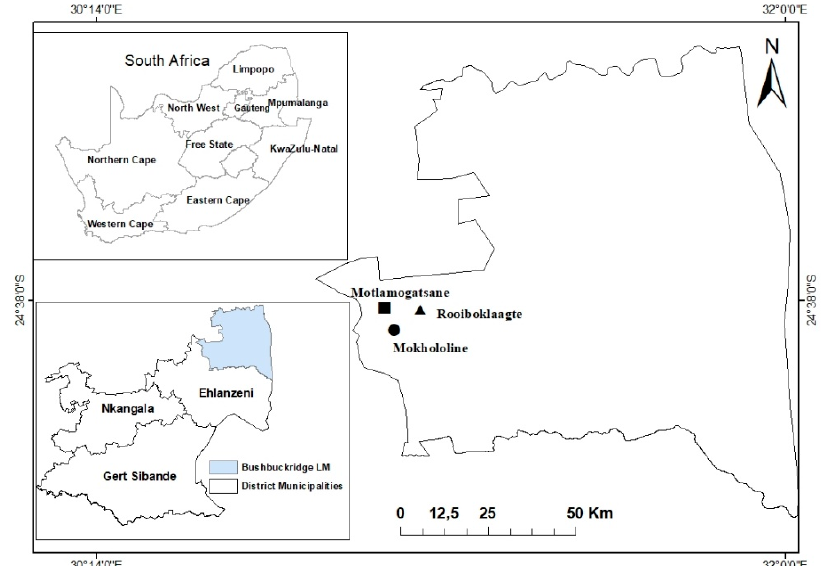
Figure 1. Location of Mokhololine, Motlamogatsane, and Rooiboklaagte B in Bushbuckridge Local Municipality (LM), Ehlanzeni District, Mpumalanga Province, South Africa.